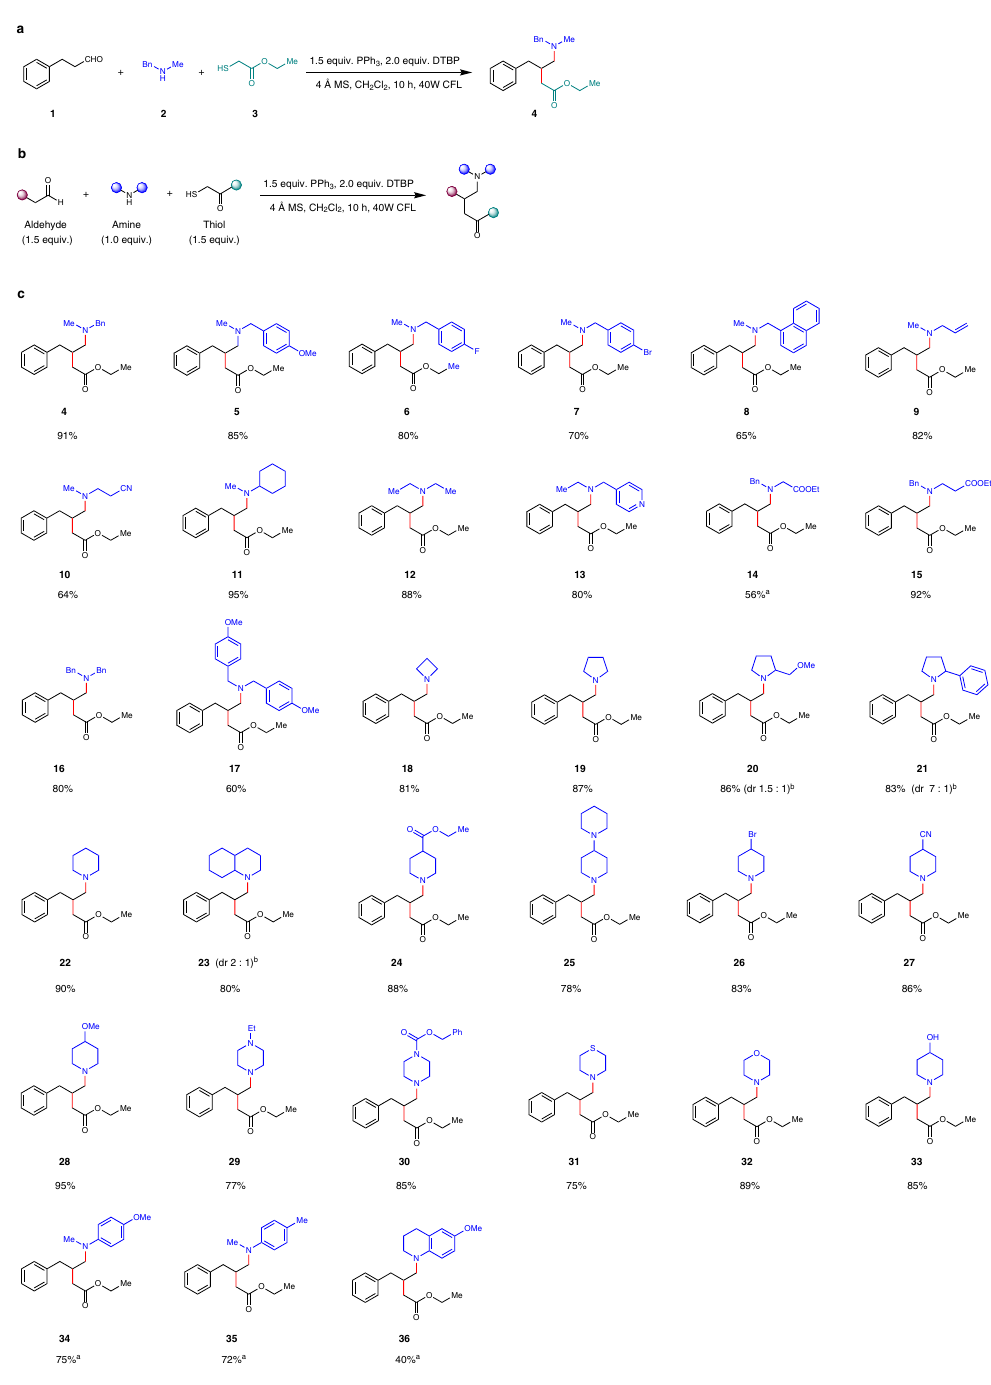
Fig. 2 Scope of the radical homo Mannich reaction. a The model reaction. b Optimal reaction conditions. DTBP Di-tert-butyl peroxide, MS molecular sieves. c Scope of the amine partner. a triethyl phosphite (1.5 equiv.) was used instead of PPh 3 . b the dr value was based on 1 H